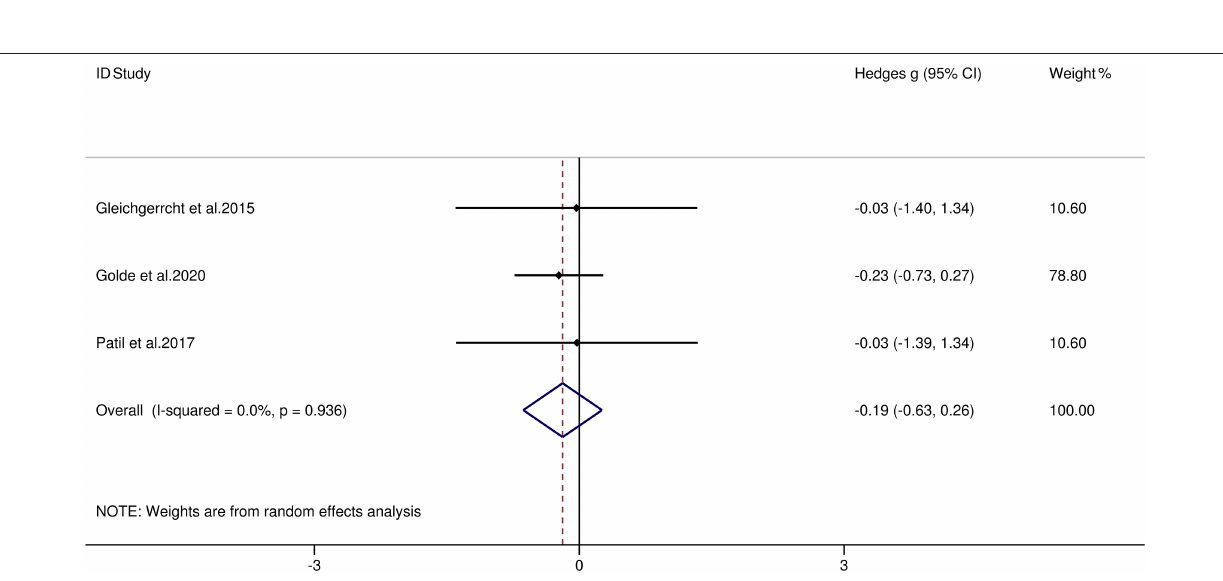
Frontiers in Psychiatry |